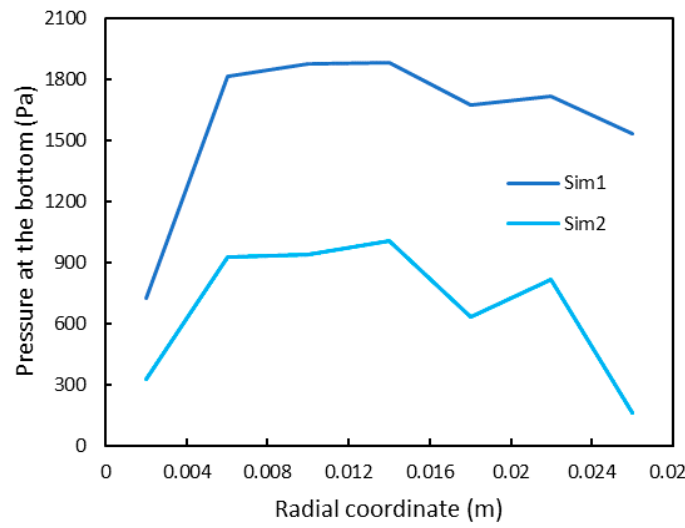
Figure 8. Radial trend of the normal stress at the bottom of the column.